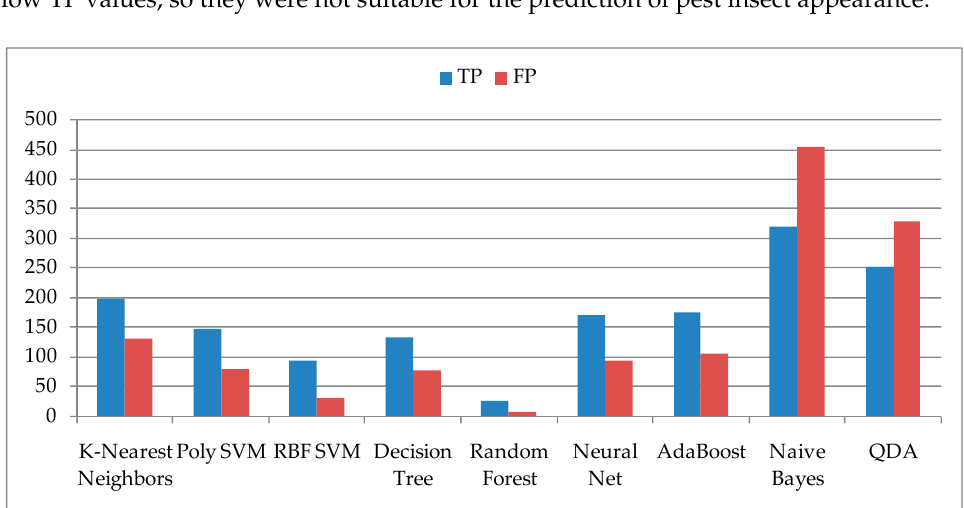
Table 3. Accuracy and elements of the confusion matrix after checking the ML model on the testing dataset. ML Model